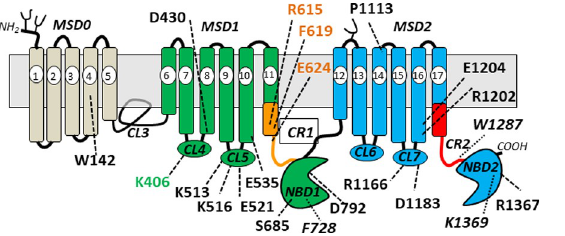
Fig 7. Location of amino acids found essential for stable expression of human MRP1 in mammalian HEK cells. Shown are the locations of amino acids identified in this study and in previously published studies [48, 59, 63, 88] or in unpublished work (Cole laboratory) to be essential for stable MRP1 expression in HEK cells. Amino acids are considered essential if their mutation to a non-conservative or conservative amino acid reduced MRP1 levels by > 80% as measured by immunoblotting. Critical amino acids identified in the present study are colored to match their domains ( green , orange ). Those from previous studies are uncolored in regular font while those from unpublished work are uncolored in italics . MSD, membrane spanning domain; CL, cytoplasmic loop; NBD, nucleotide binding domain; CR, connecting